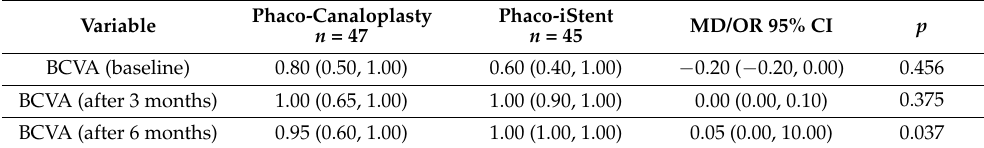
Table 2. Comparison of BCVA according to type of surgery: baseline vs. further measurements.